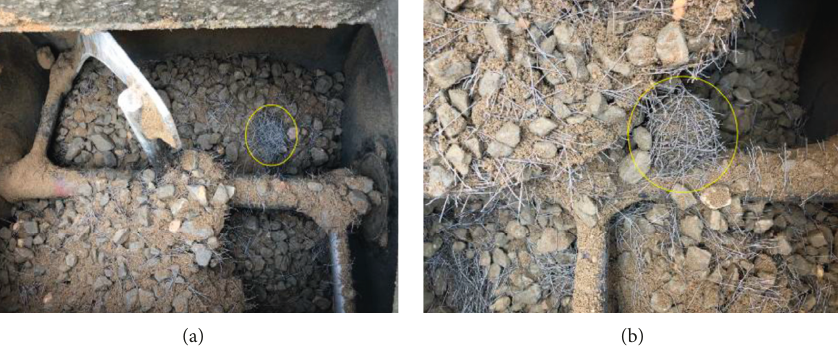
Figure 2: The ball of steel